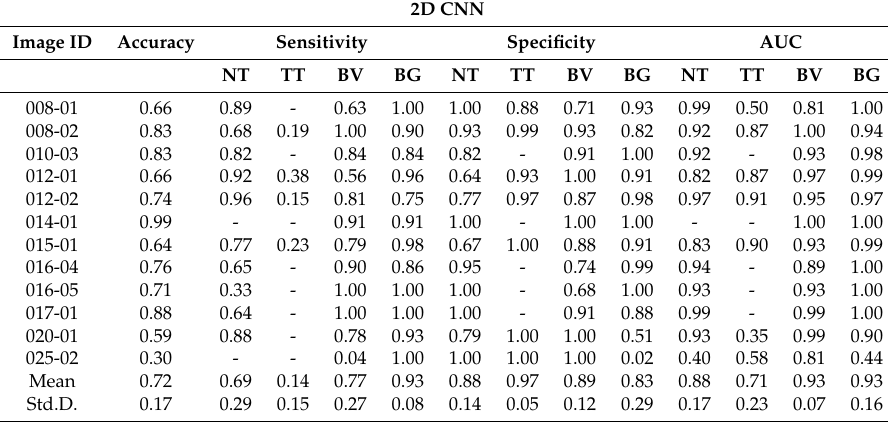
Table A4. Overall results for the 2D CNN. Accuracy, sensitivity, specificity, and AUC are calculated for each class. NT: Normal tissue, TT: Tumor tissue, BV: blood vessels, BG: Background. 2D CNN Image ID Accuracy